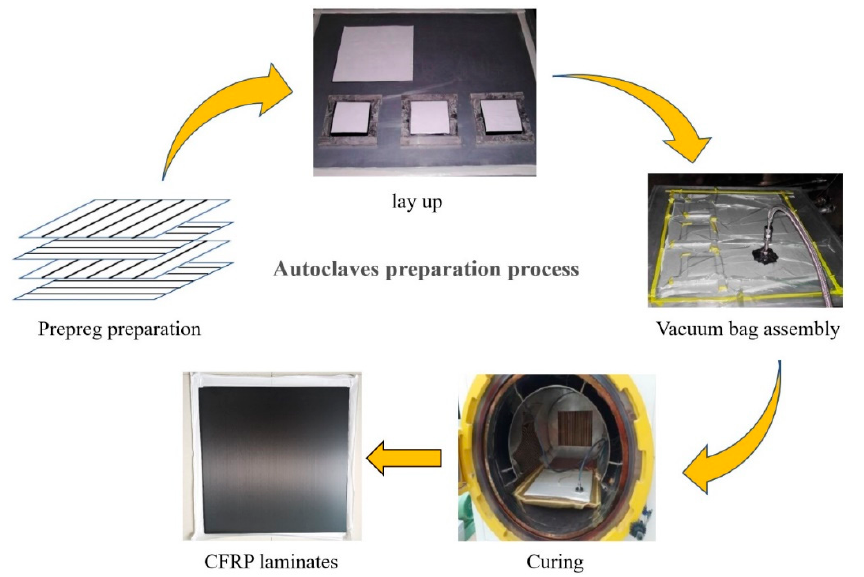
Figure 1. CFRP composite preparation process.